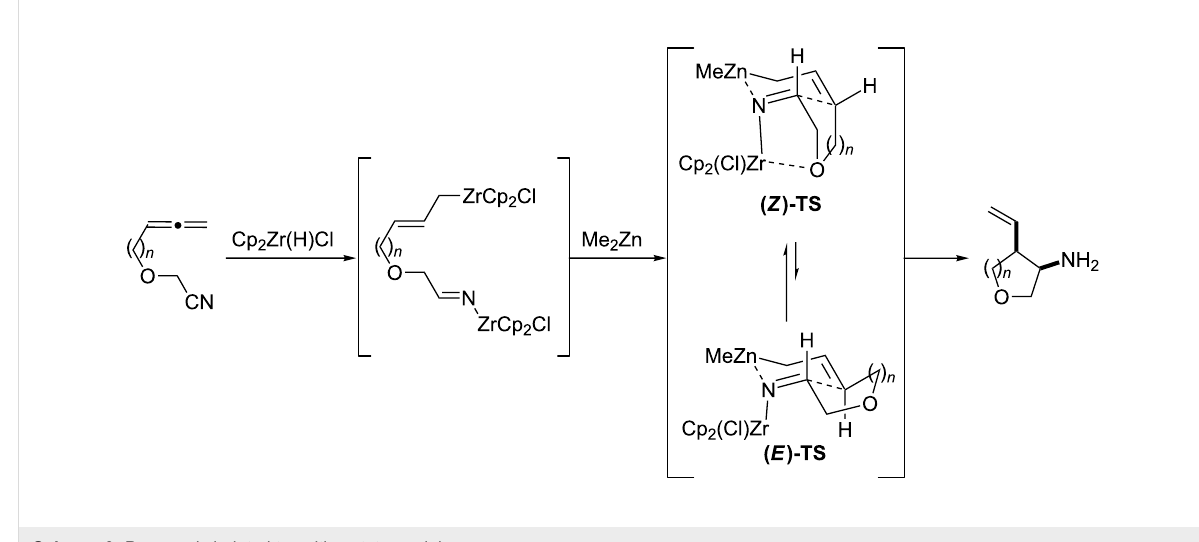
Scheme 3: Proposed chelated transition state model.